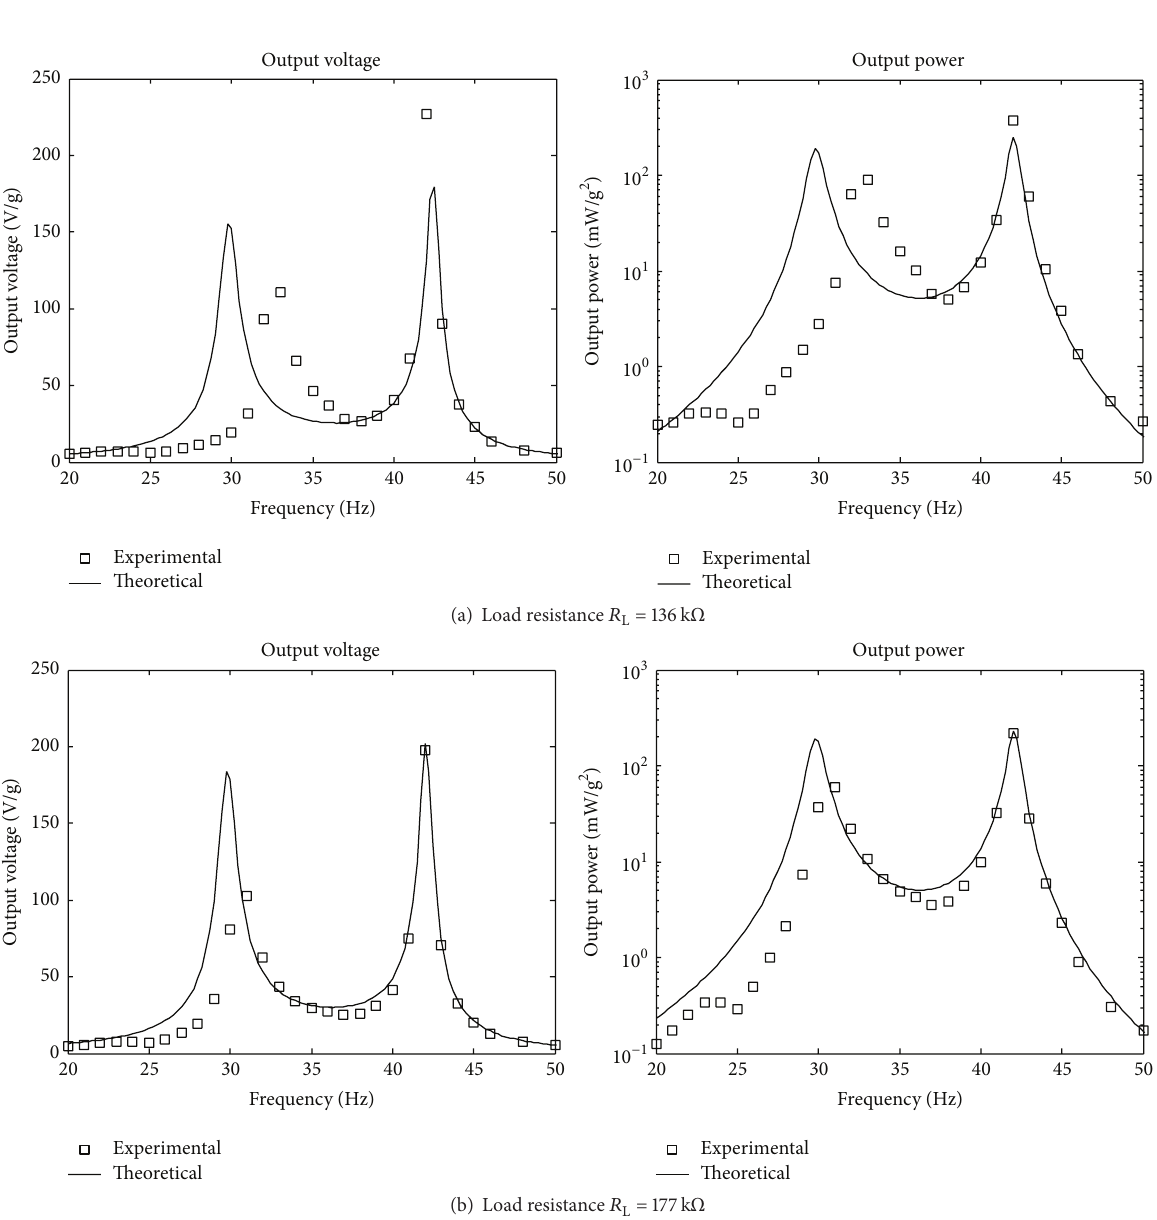
the CPEH cannot only enhance the output performances but also broaden the frequency